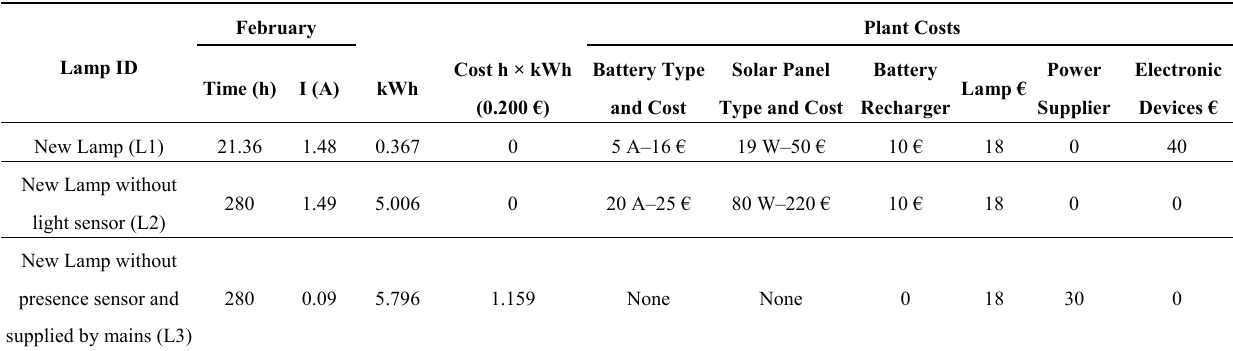
Table 6. Current consumption and operating time of new and old